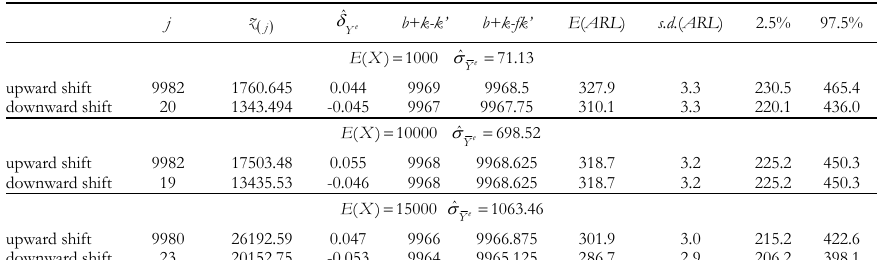
Off-target ARL computations for